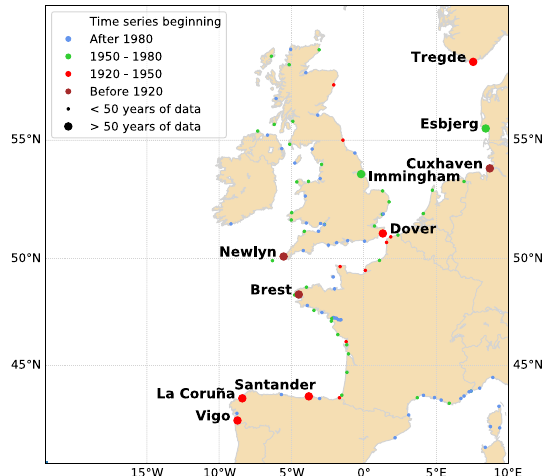
Figure 1. Location of the tide gauge stations from the GESLA-2 database. Labelled stations are the ones used in this